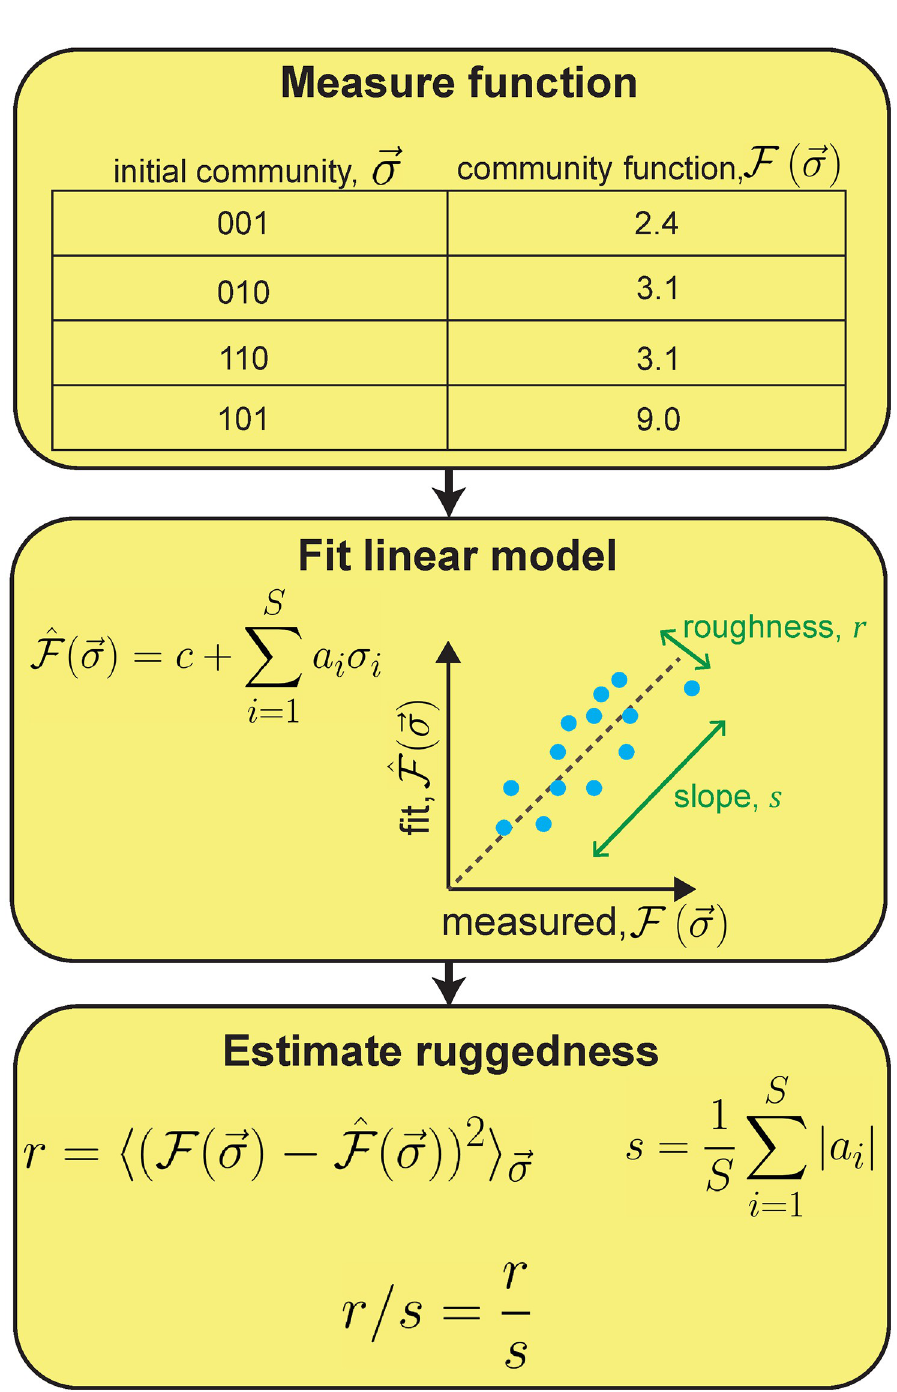
Fig 4. Example of the workflow for calculating the ruggedness of ecological landscapes. The roughness-slope ratio r / s quantifies the deviation from linearity of the landscape. It is calculated by fitting the measured community function landscape with a linear model ^ F ð ~ s Þ and then estimating r and s from the fit. The roughness, r , measures the average error of a linear fit to the community function landscape and the slope, s , measures the magnitude of the change in ^ F . The calculation of other ruggedness metrics follows a similar pattern, but with different mathematical quantities being